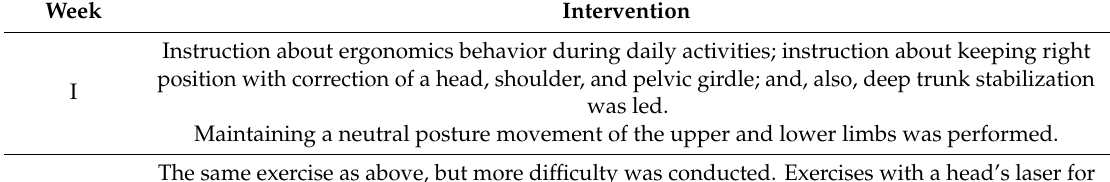
Table 1. The details of the rehabilitation protocol.